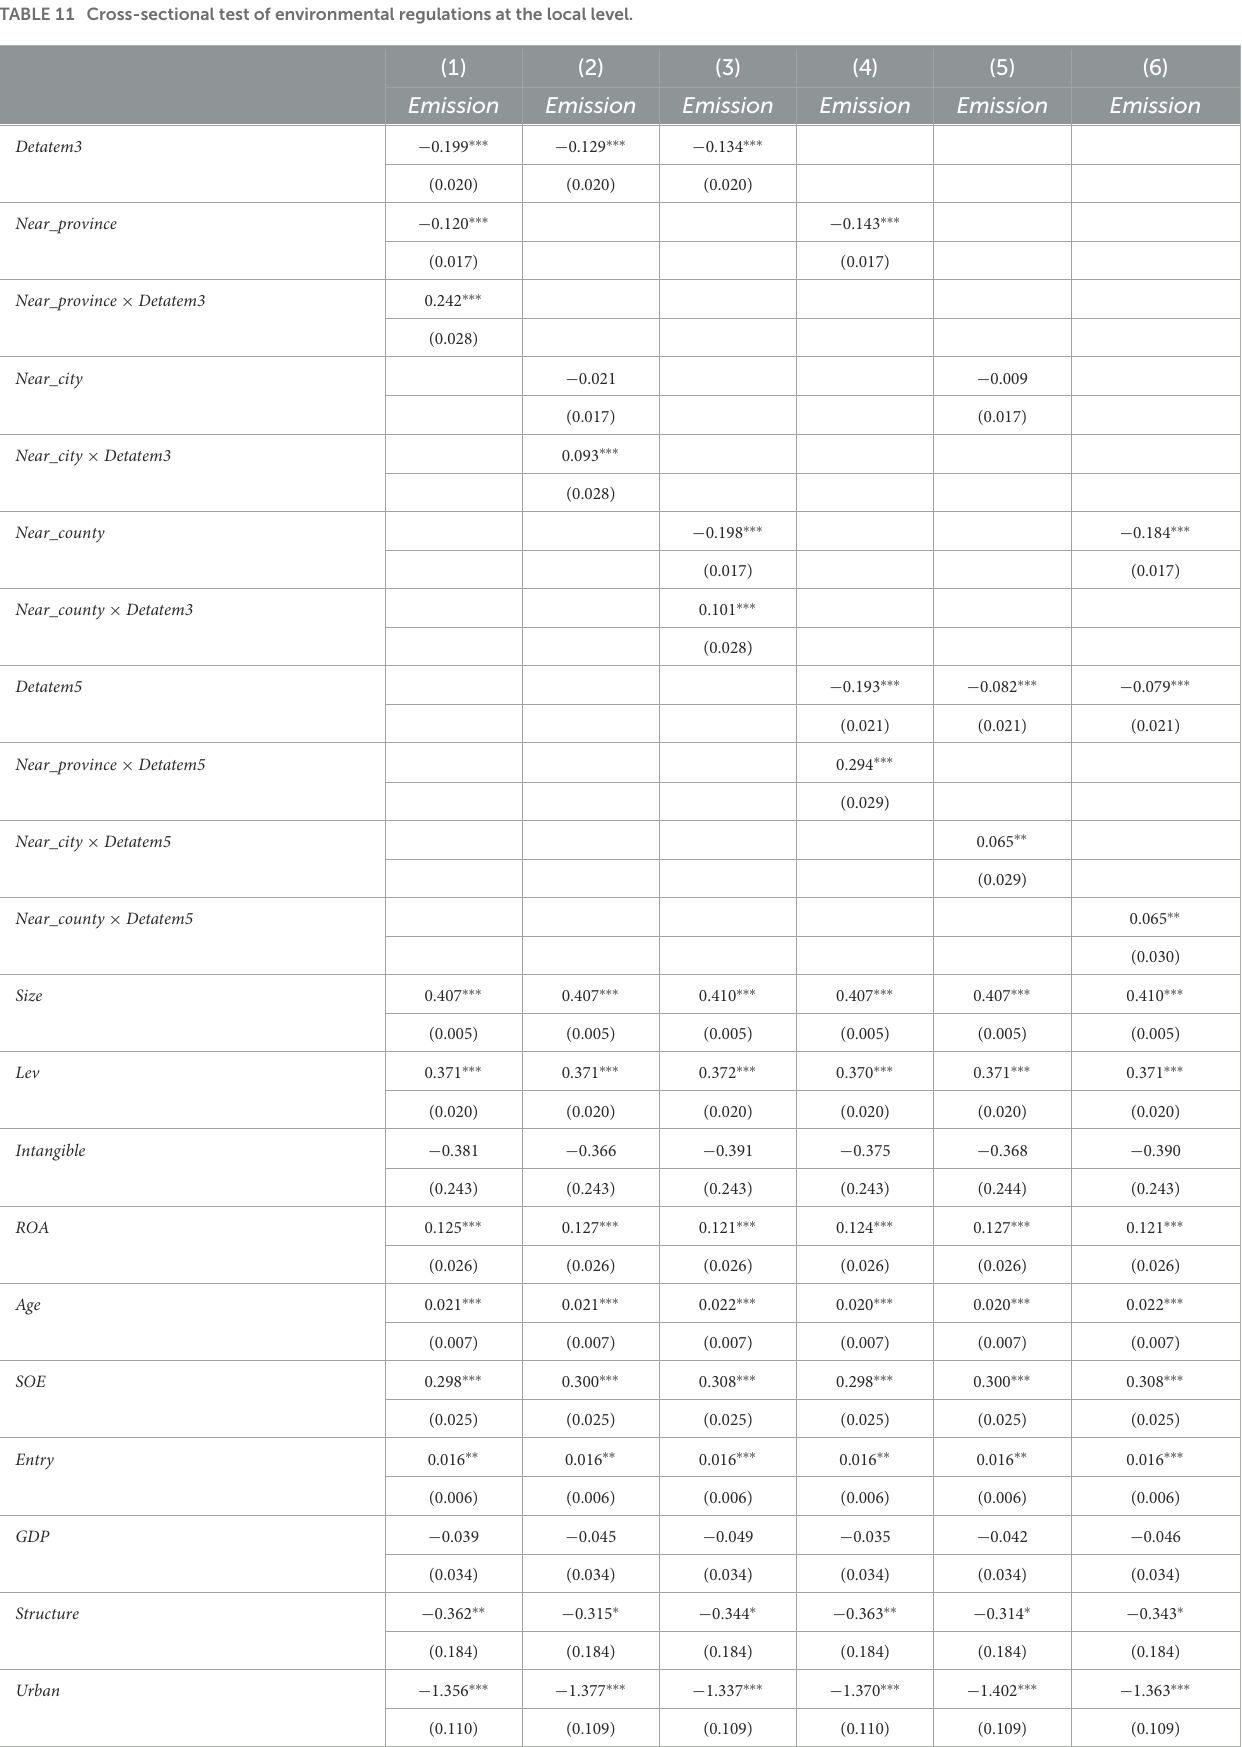
TABLE 11 Cross-sectional test of environmental regulations at the local